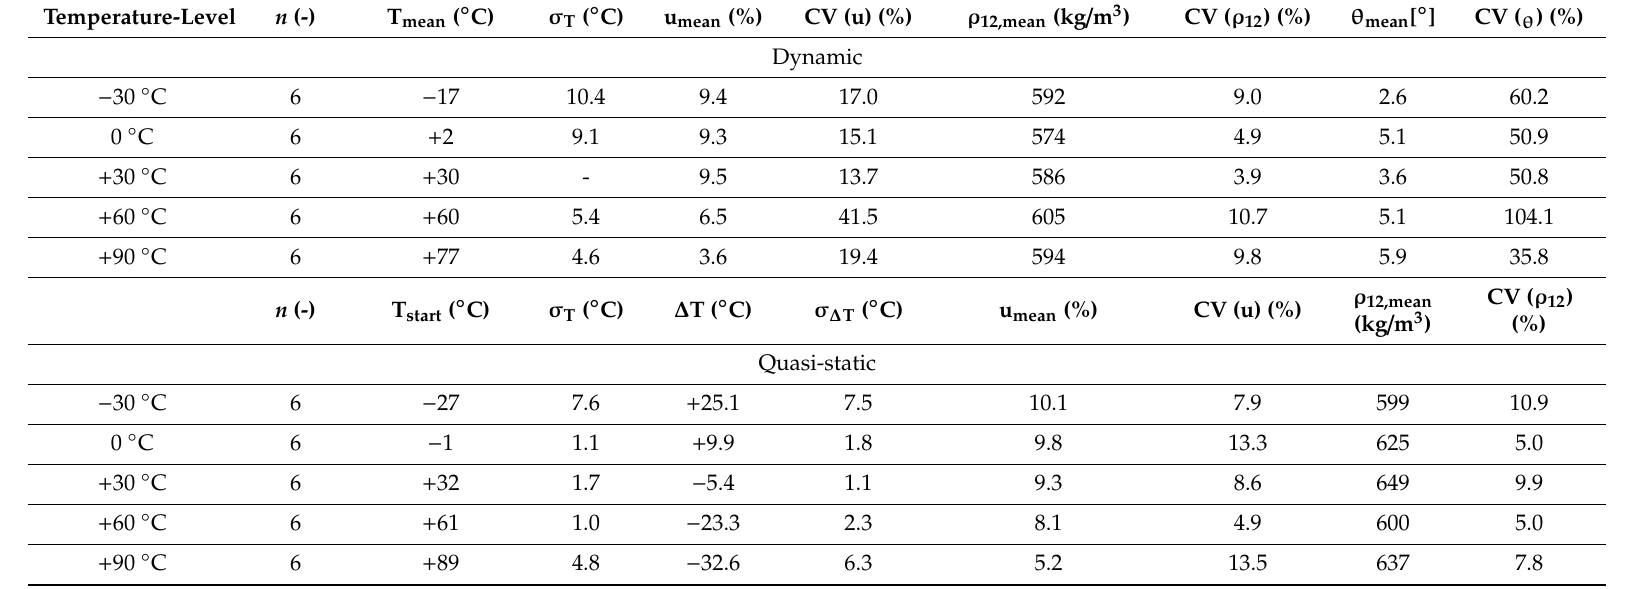
Table 2. Main statistics of the temperature, moisture content, and density